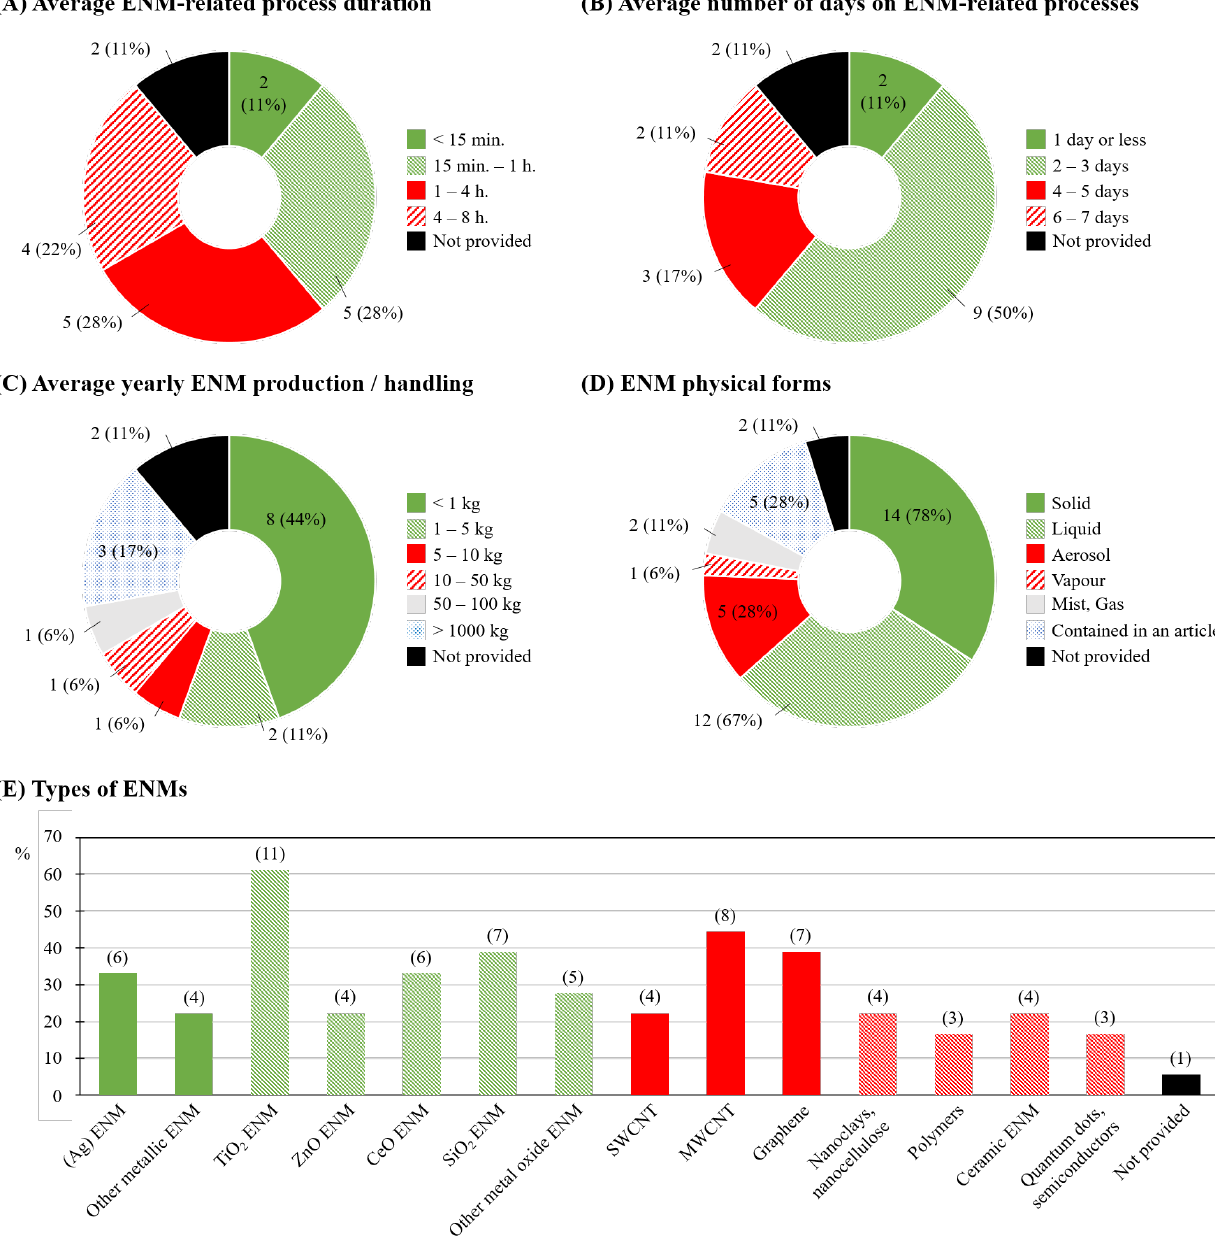
Figure 2. Engineered nanomaterials (ENM) characteristics and handling specificities: ( A ) average working process duration; ( B ) average number of days involving ENM-related working processes; ( C ) average yearly production/handling of ENM; ( D ) physical forms of ENM; ( E ) types of ENM manufactured/handled with number of respondent companies indicated in brackets. S/MW-CNT: single-/multi-walled carbon nanotubes.